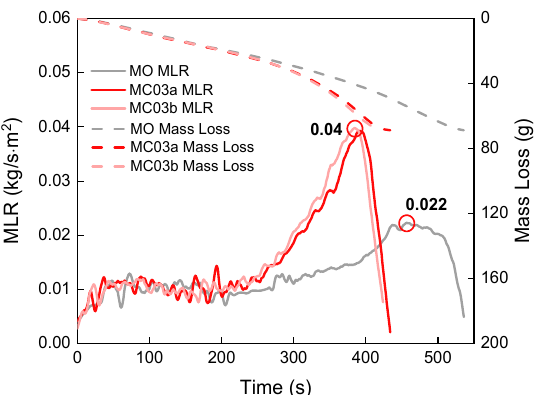
Figure 20. Mass loss rates and mass losses for heptane fuel in Test MO and Test MC03.